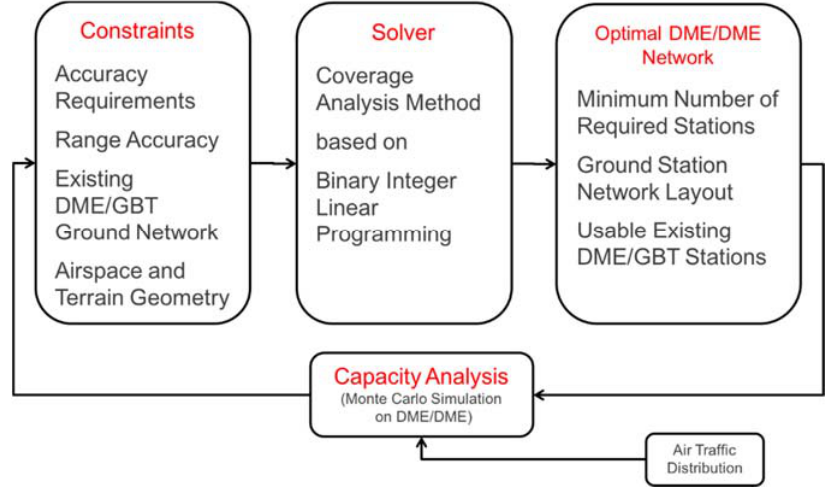
Figure 4. DME/DME network placement procedures.